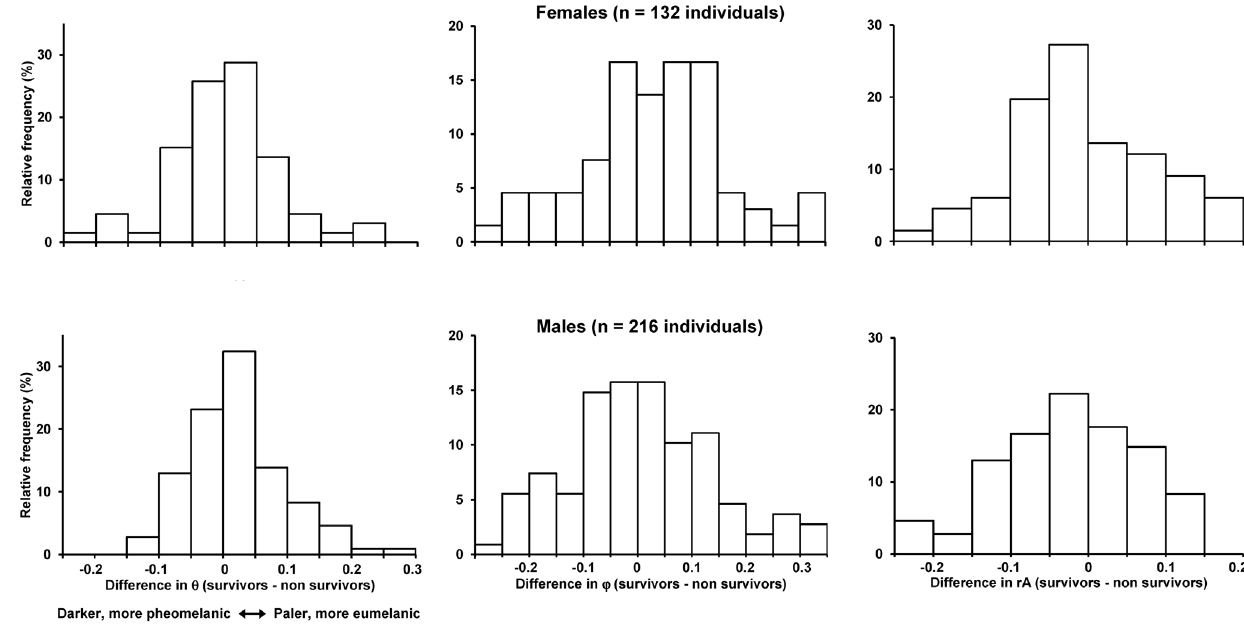
Figure 1. Frequency distribution of the difference in tetrahedral color components between female (upper panels) or male (lower panels) barn swallows that survived or did not survive from one breeding season to the next. Each survivor was matched to a non- surviving individual of the same sex and age, sampled in the same year and, whenever possible (91% of the cases), breeding colony and capture date (see